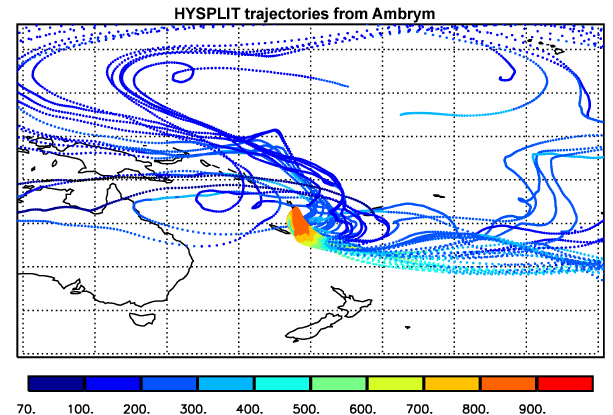
Figure 14. Fifteen-day forward trajectories initialized from the lo- cation of Ambrym Volcano at 1373m every hour on the 10 and 11 January 2005 calculated with the HYSPLIT model. The color scale represents the pressure (in hPa) of the air masses along the